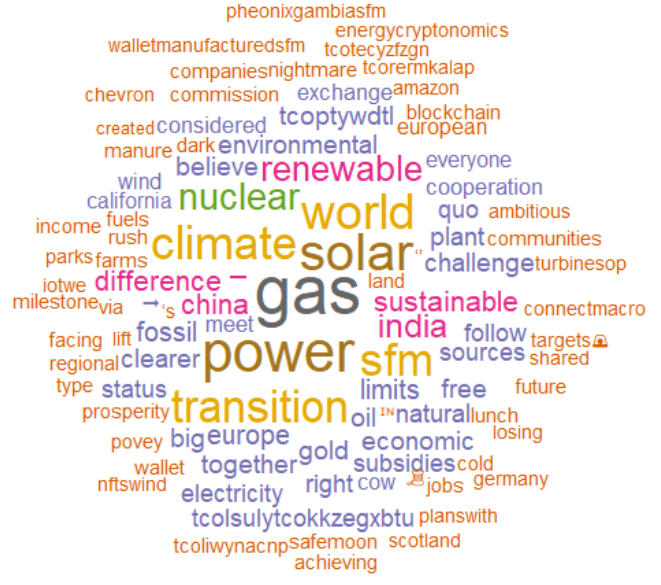
Figure 4. Wordcloud period 1.